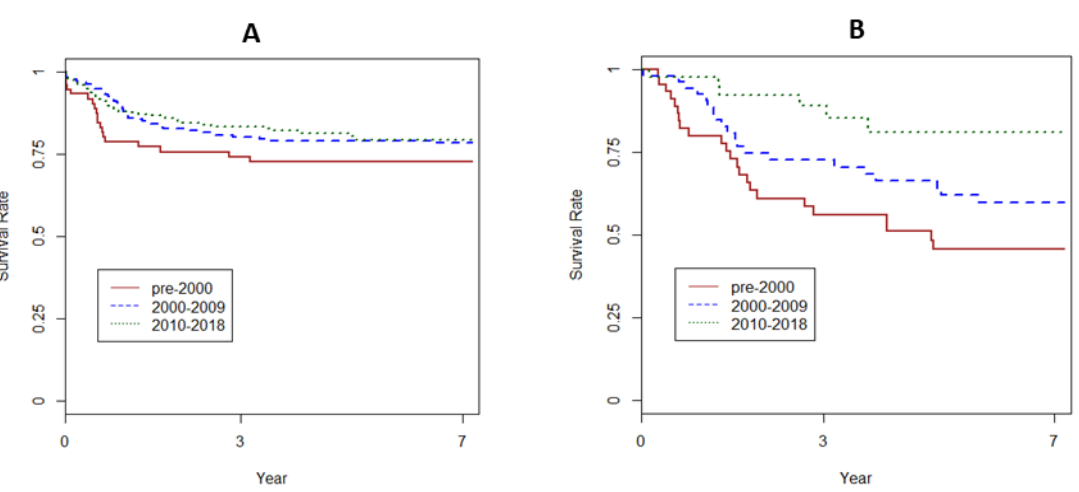
Figure 5 Patient survival after LT for HB by era. B. Patient survival after LT for HCC by era. (SRTR Figure 5. ( A ) Patient survival after LT for HB by era. ( B ) Patient survival after LT for HCC by era. 1988-2018. (SRTR